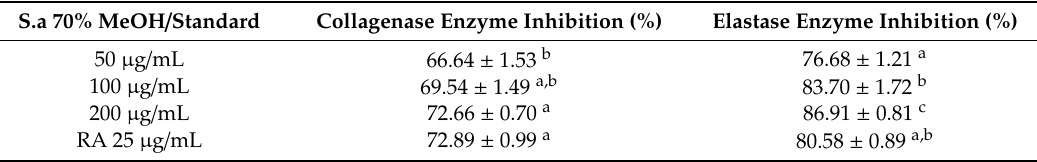
Figure 1. β carotene linoleic acid peroxidation activity of S. aramiensis extracts: Values = mean ± SD, statistical analyses by Games–Howell comparison test; bars with the same lowercase letters (a–d), same symbols (*, **) and Roman numerals (I, III) are not signi fi cantly ( p > 0.05) different, n = 3. S.a 70% MeOH; S. aramiensis 70% methanol extract, S.a 70% EtOH; S. aramiensis 70% ethanol extract, S.a inf; S. aramiensis 2% infusion. Table 3. Collagenase and elastase enzyme inhibition activities of S. aramiensis 70% MeOH extract and rosmarinic